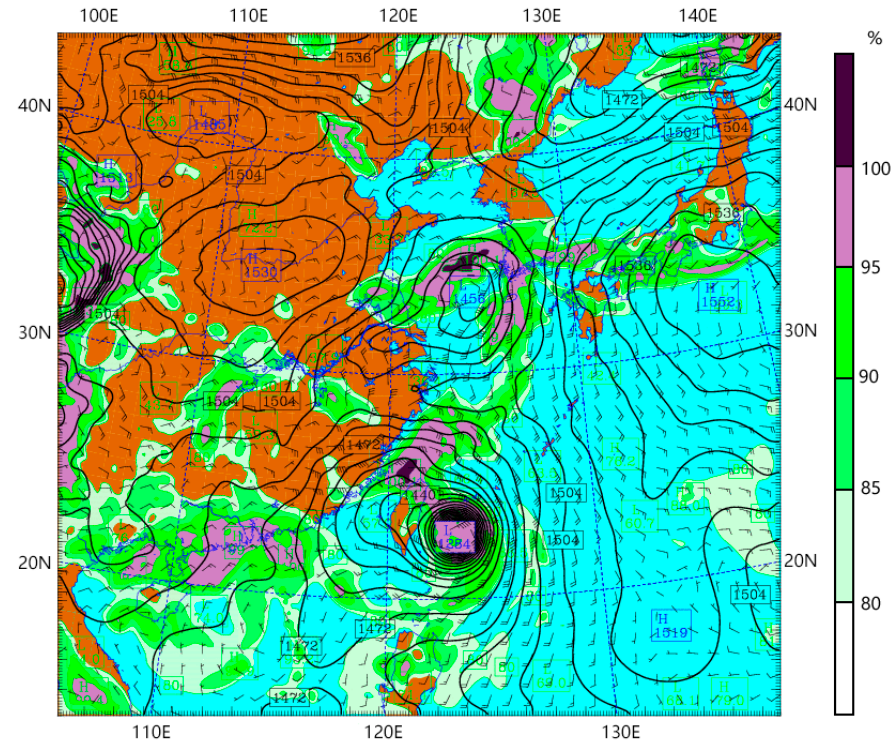
Figure 11. Relative humidity and potential height of the MALAKAS typhoon with the pressure at 850 hPa layer at 02:00 on 17 September.